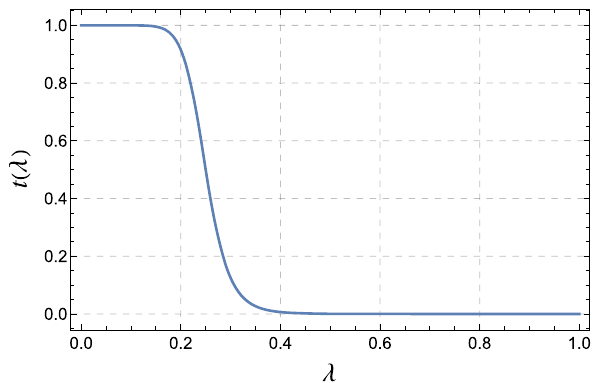
Fig. 5 Transition function t (λ) used to switch off the